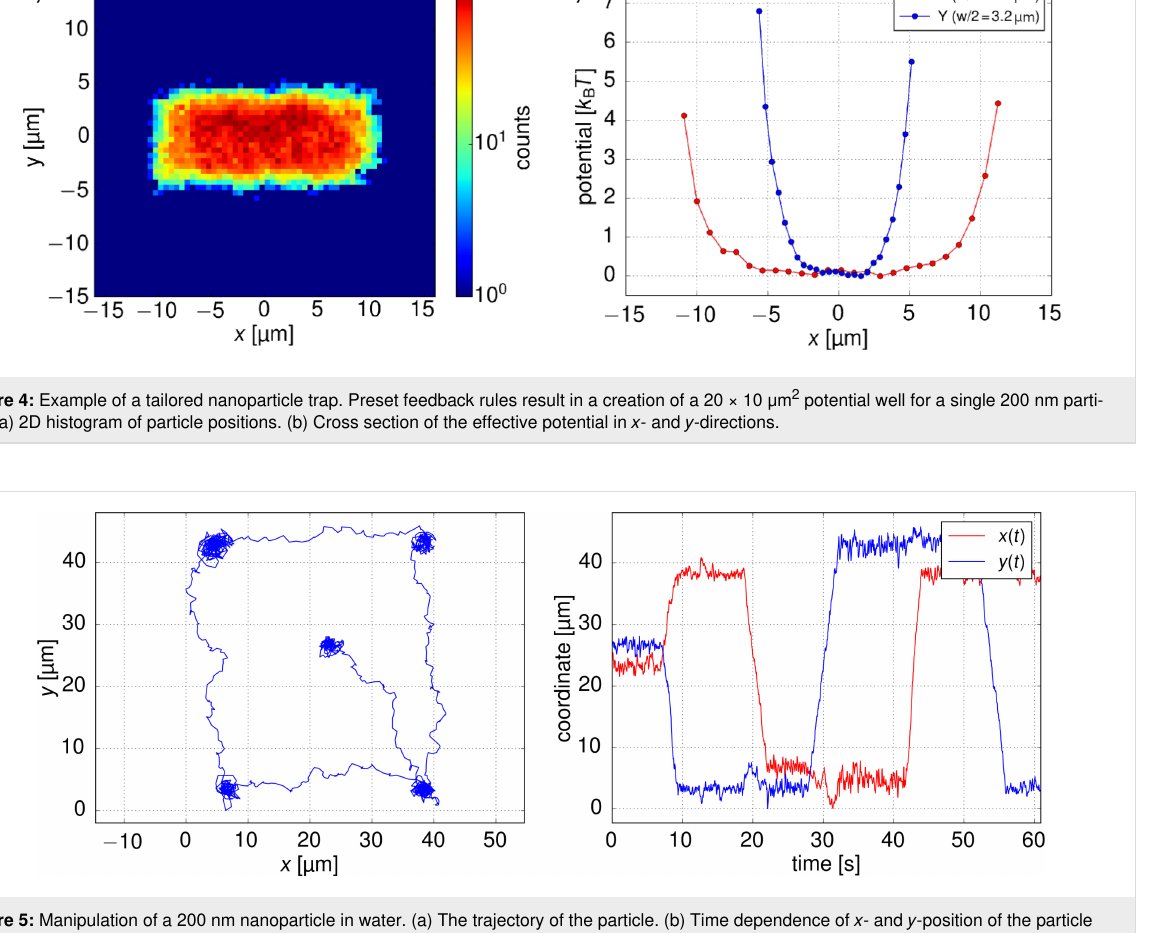
Figure 5: Manipulation of a 200 nm nanoparticle in water. (a) The trajectory of the particle. (b) Time dependence of x - and y -position of the particle during the